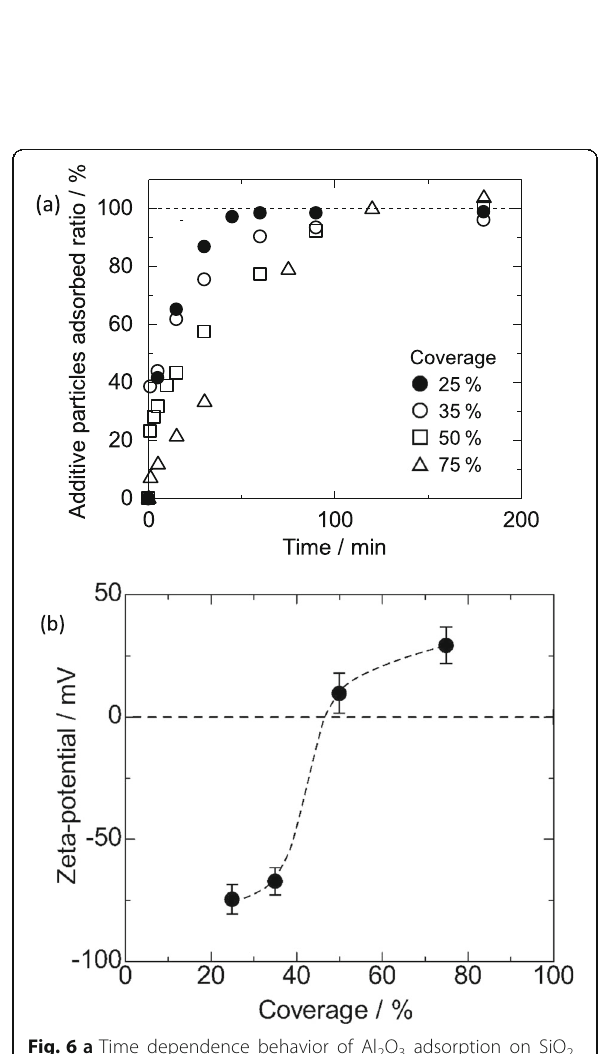
Fig. 6 a Time dependence behavior of Al 2 O 3 adsorption on SiO 2 particle for various suspension coverage ratios. b Zeta potential of Al 2 O 3 -SiO 2 composite particles obtained using varying coverage percentage. Three independent samples were prepared and an average of five measurements were carried out to obtain the standard